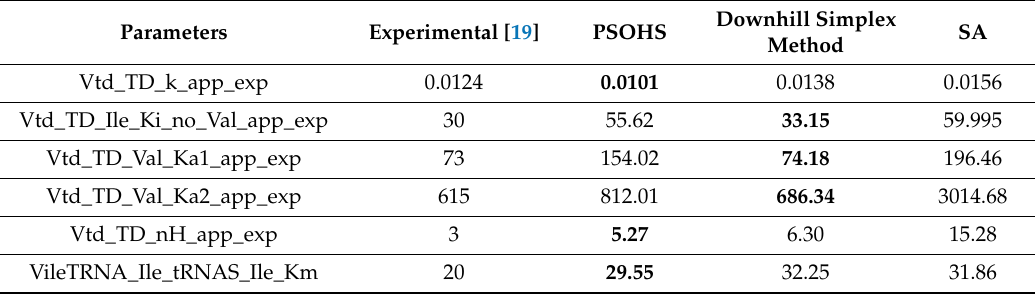
Table 5. List of kinetic parameter values for isoleucine with the experimental values.